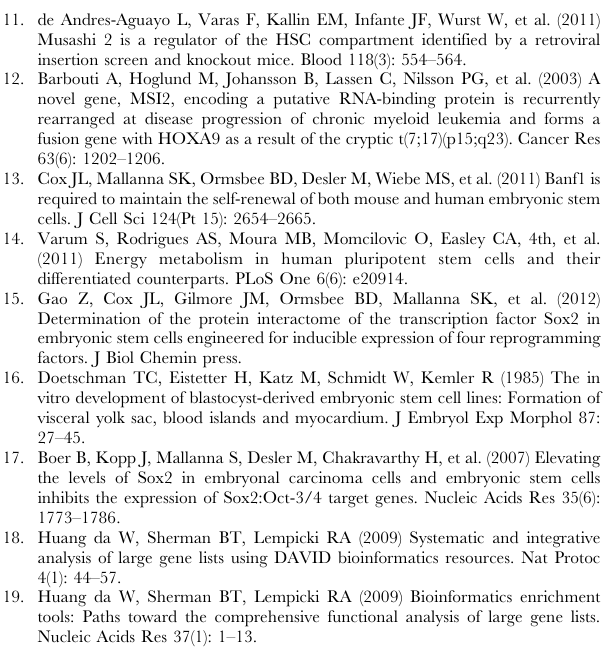
Table S2 Genes more highly expressed ( . 1.9-fold, , 2.5-fold) in control scr-shRNA treated ESC. Table S3 Gene ontology heatmap of transcripts induced . 2-fold in Msi2-shRNA # 1 treated ESC. Table S4 Gene ontology heatmap of transcripts induced . 2-fold in scr-shRNA treated